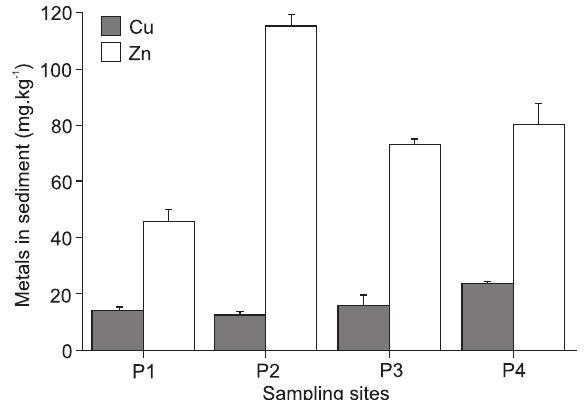
Figure 2. Zinc concentration (mean ± standard error) and